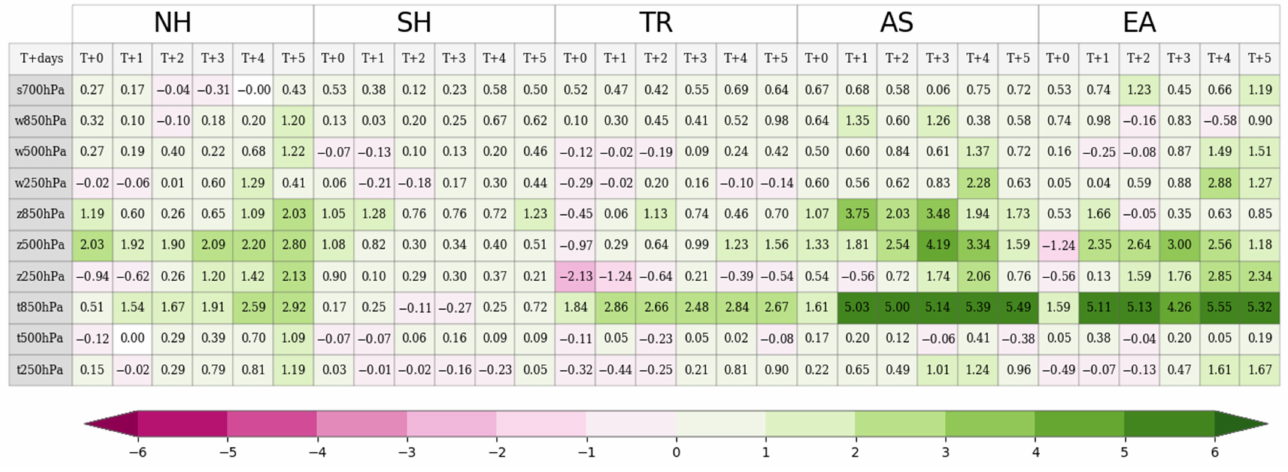
Figure 12. Scorecard of the RMSE improvement rates for the specific humidity at 700 hPa (s700 hPa); wind speed at 850 hPa, 500 hPa, and 250 hPa (w850 hPa, w500 hPa, and w250 hPa); geopotential height at 850 hPa, 500 hPa, and 250 hPa (z850 hPa, z500 hPa, and z250 hPa); and temperature at 850 hPa, 500 hPa, and 250 hPa (t850 hPa, t500 hPa, and t250 hPa) in the Northern Hemisphere (NH), Southern Hemisphere (SH), Tropics (TR), Asia (AS), and East Asia (EA) for a five-day